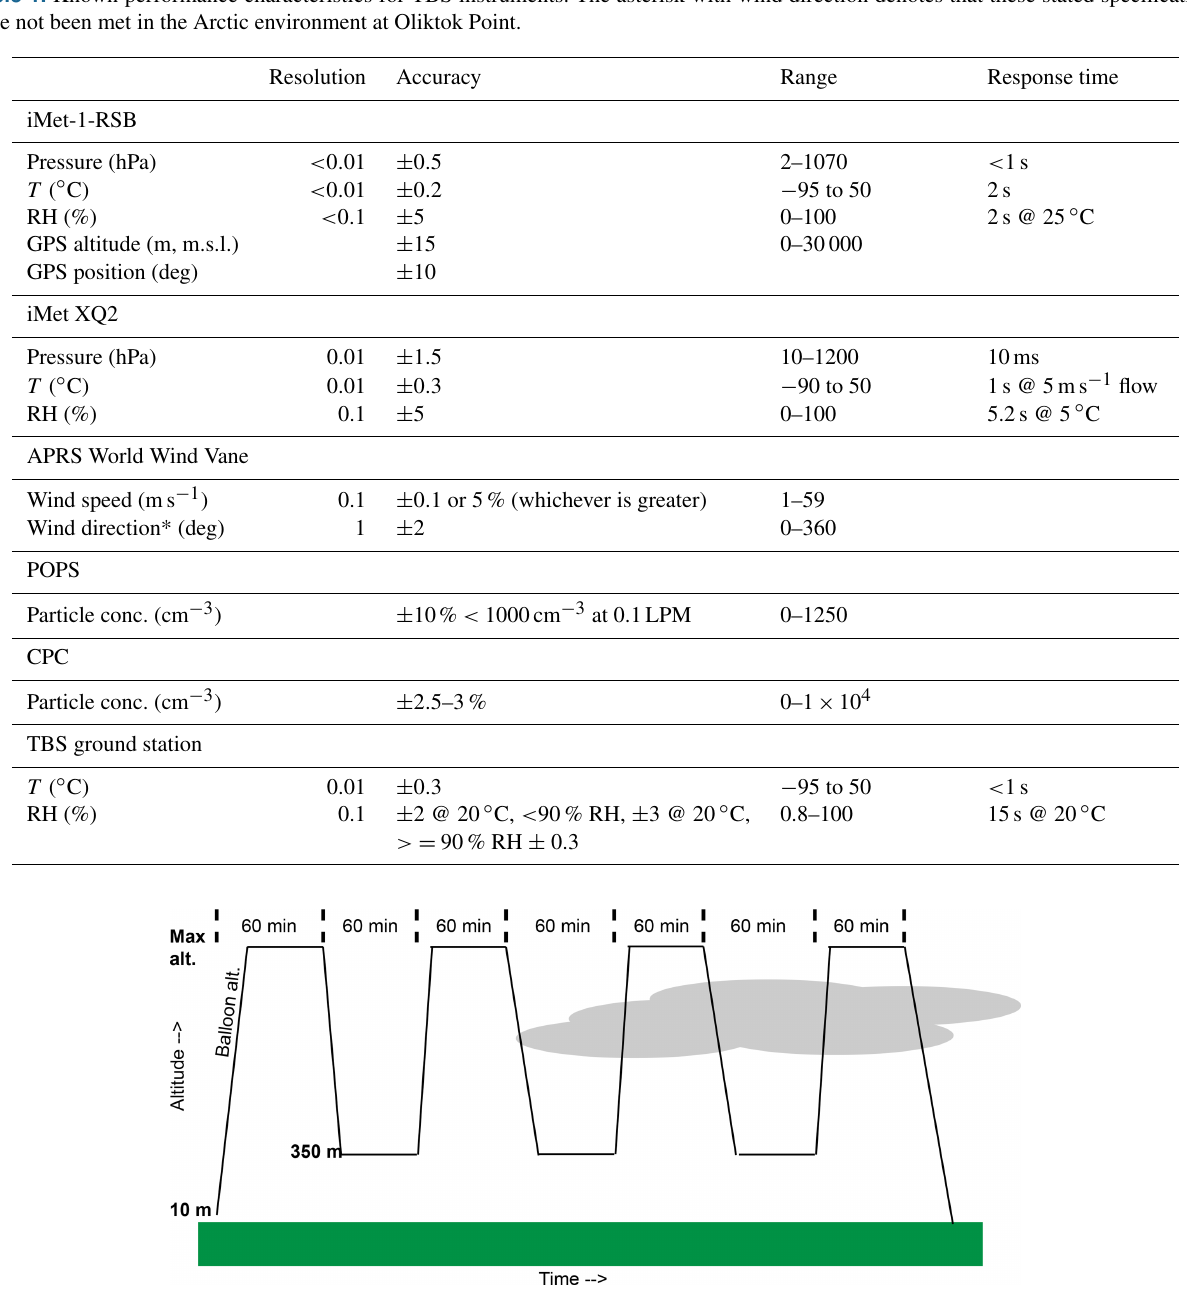
Figure 2. An illustration of the proposed TBS flight pattern for clear or cloudy conditions. The black lines are the proposed flight pattern, with time on the horizontal